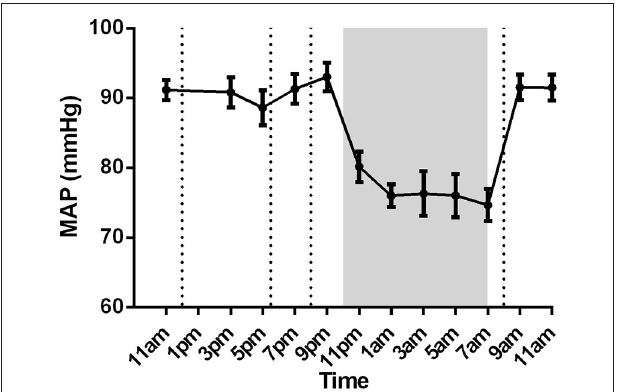
FIGURE 4 | Mean arterial pressure of nine healthy male subjects (mean ± SEM). Lunch, dinner, evening snack and breakfast are marked with dotted lines in respective order. Night-time (lights off at 10 p.m; lights on at 7a.m) is marked with shaded